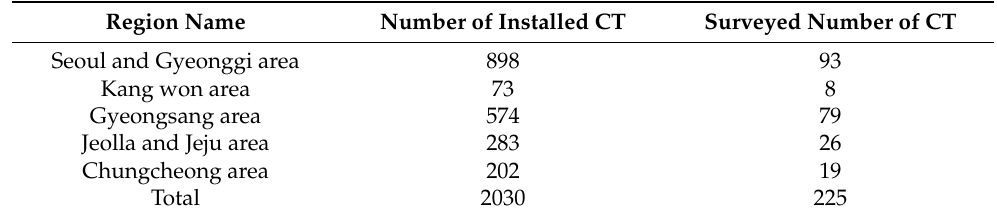
Table 1. Regional distribution number of installed CT and surveyed number of CT in